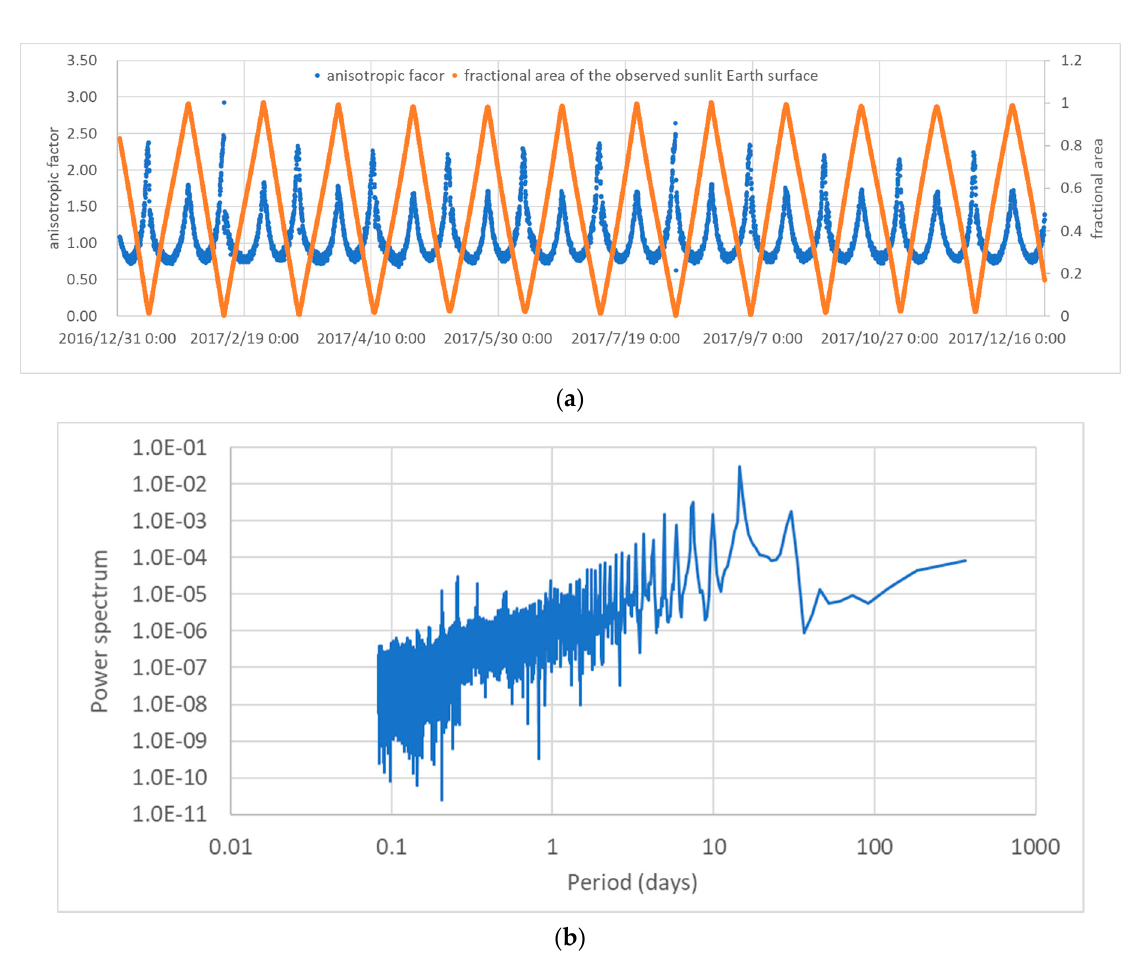
Figure 12. The time series of the global shortwave anisotropic factor of Earth TOA in the Moon-based view and the fractional area of the observed sunlit Earth surface in 2017 ( a ) and the power spectrum of the time series of the shortwave anisotropic factor ( b ). The fractional area of the observed sunlit Earth surface was calculated as ratio of the sunlit area to the maximum sunlit Earth area.